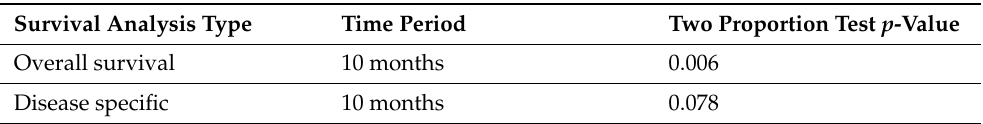
Table 2. Lower survival probability in PC patients assessed at a single time point for high miR-155HG and low SHIP-1 expression (Figure